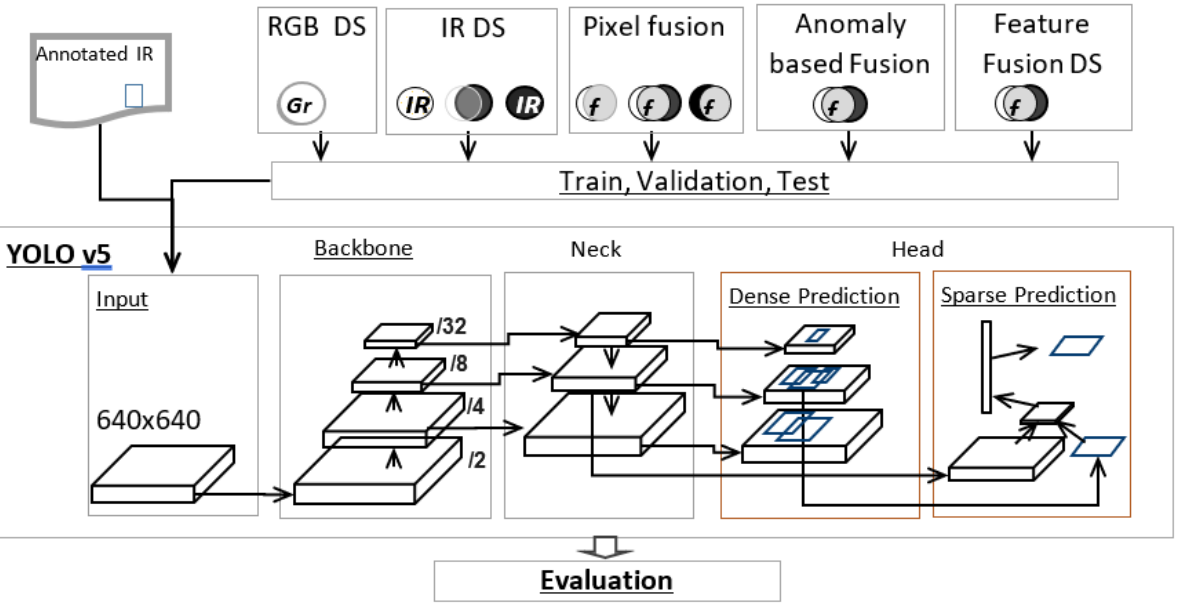
Figure 9. Post-process phase where each prepared training DS is being fed as a YOLO V5 model input, with the IR annotated images as GT to train the network.